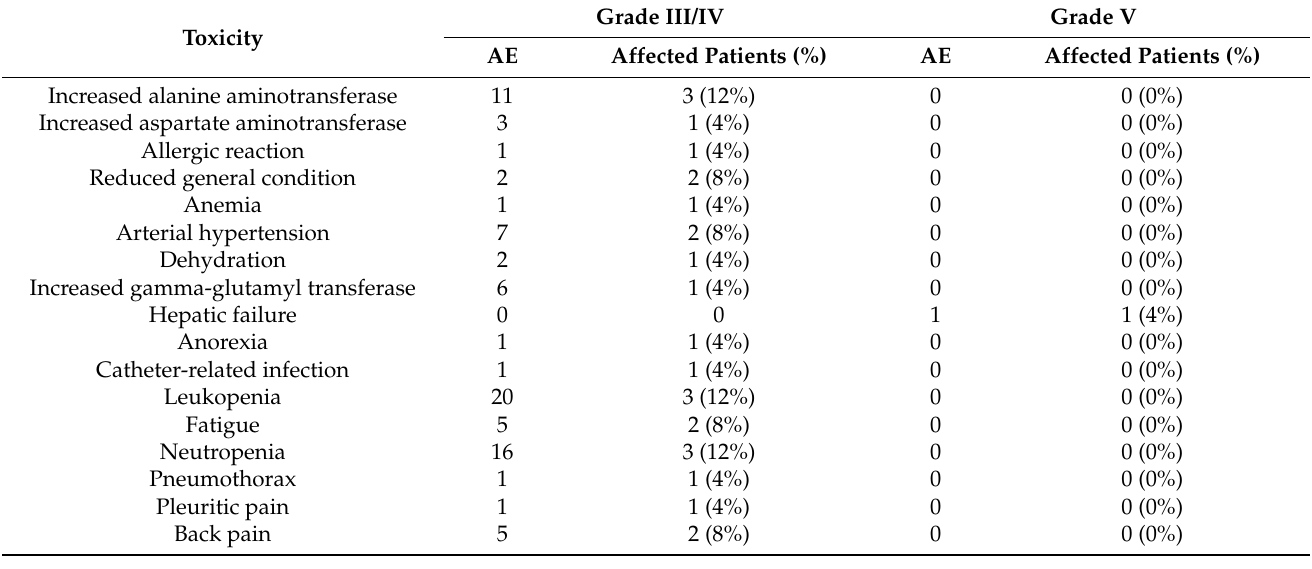
Table 2. All adverse events (AE) grade ≥ 3.